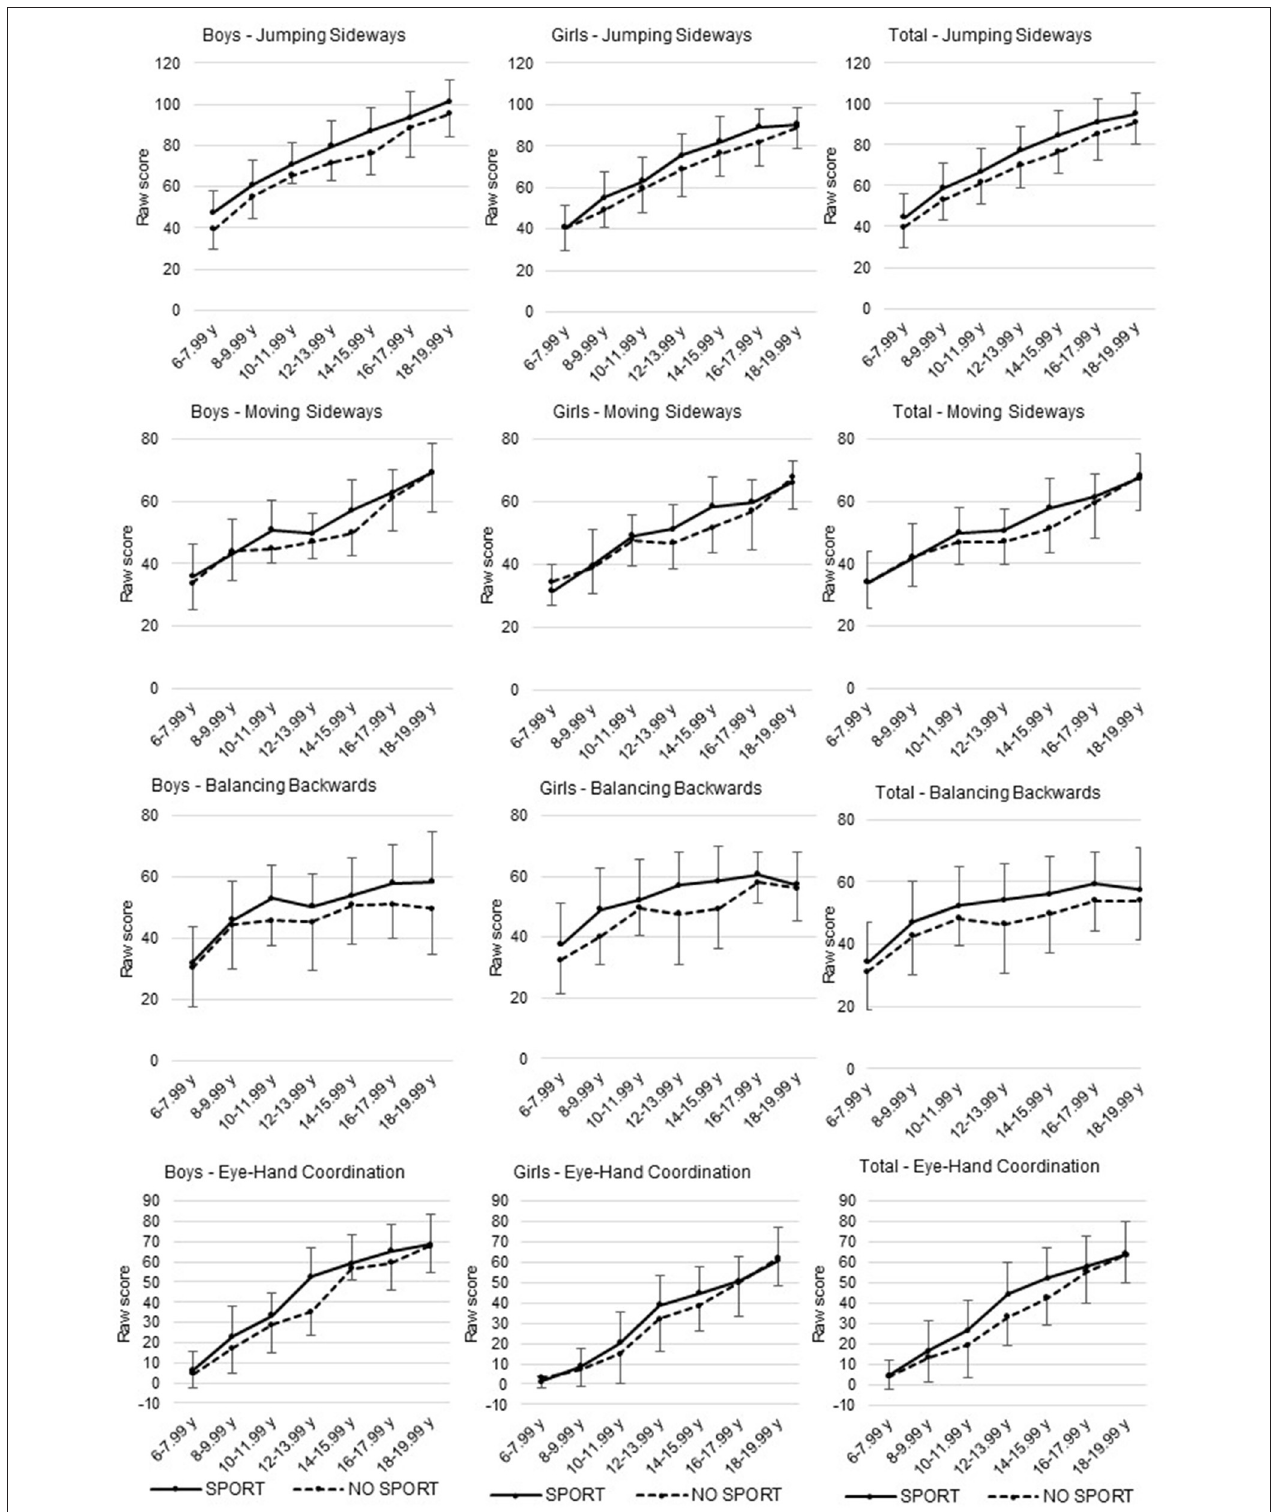
FIGURE 2 | Differences in raw scores on each KTK3 + test item for the total sample and between sex, age groups, and organised sport participation.